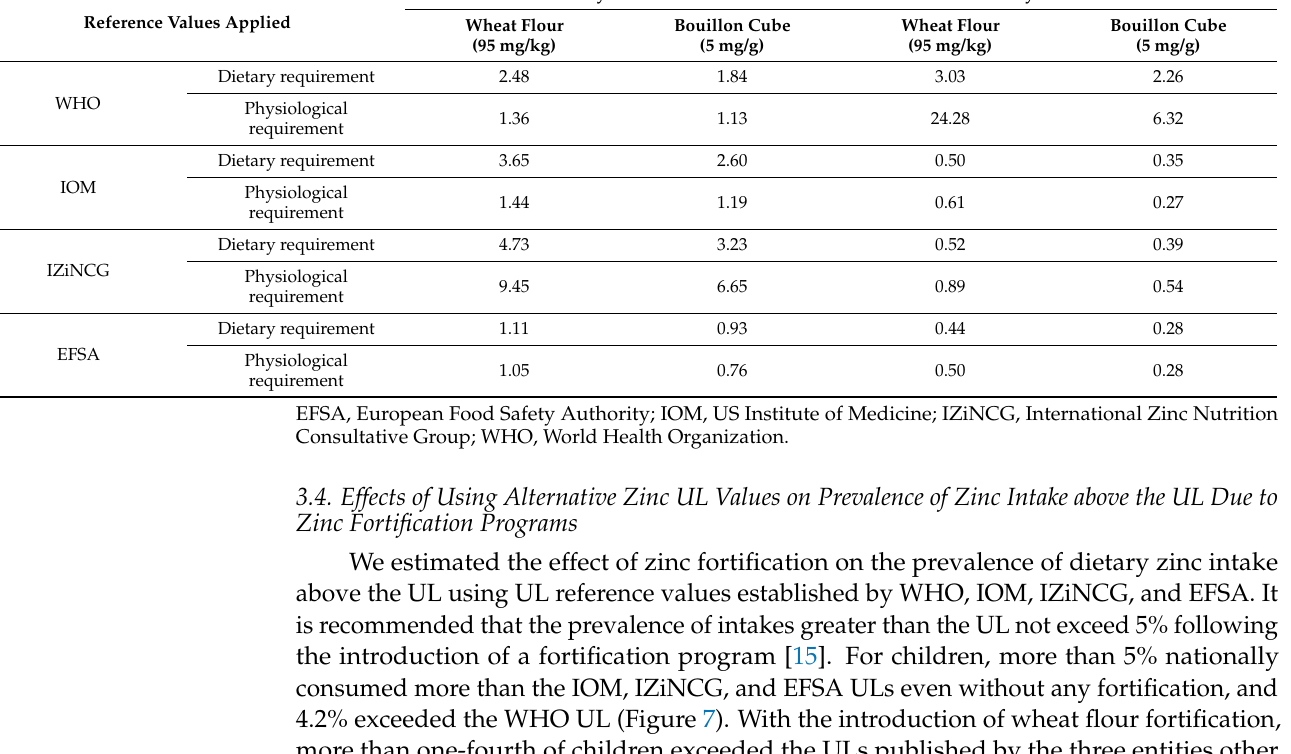
Figure 8. Prevalence (±SE) of zinc intake above the UL considering the contribution of zinc fortification programs among women in Cameroon: estimated based on WHO, IZINCG, IOM, and EFSA UL reference values. EFSA, European Food Safety Authority; IOM, US Institute of Medicine; IZiNCG, International Zinc Nutrition Consultative Group; WHO, World Health Organization; WF, wheat flour; BC, bouillon cubes; UL, tolerable upper intake level 4. Discussion